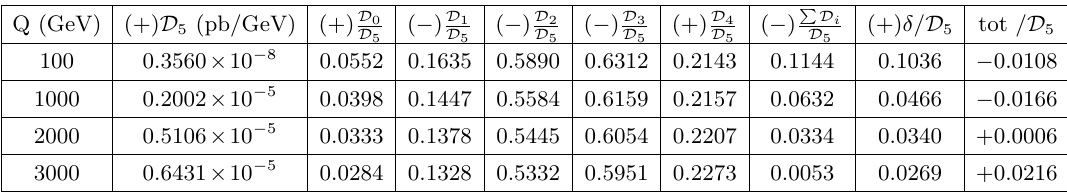
Table 1 . Contribution of large logarithms, the constant term (cid:14) (1 (cid:0) z ) and the total SV correction (tot) to the di-lepton invariant mass distribution at 3-loop level in the ADD model for 13 TeV